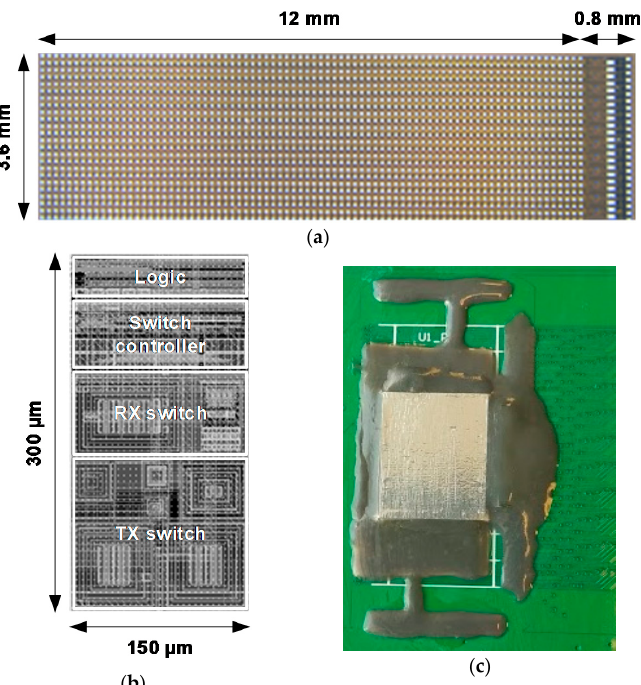
Figure 8. ( a ) Chip photograph of the ASIC, ( b ) layout of the pitch-matched element-level circuit, and ( c ) the test printed circuit board (PCB) with transducer array on top of the ASICs.